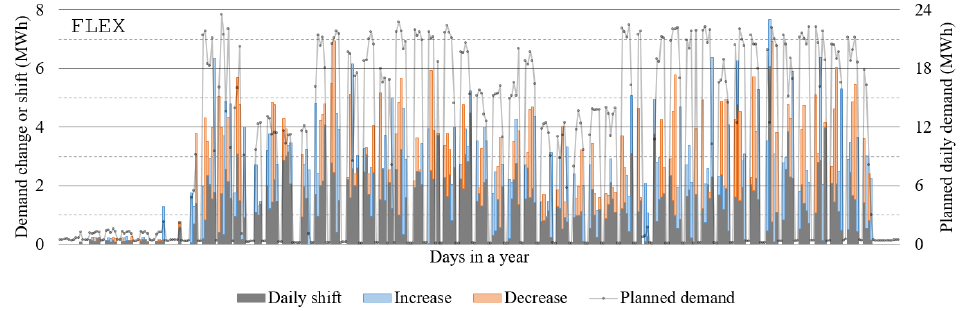
Figure 9. Volume of demand shifted from the planned operation in FLEX ; grey area shows the demand shift within the same day; blue and red areas show demand change (increase and decrease, resp.) due to the shift between adjacent